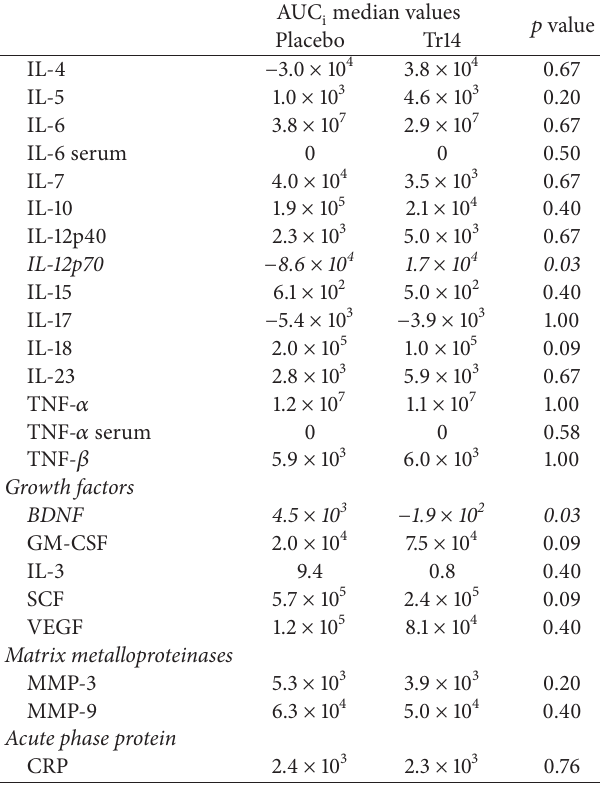
Table 2: AUC i median values from all outcome parameters and the 𝑝 value of median